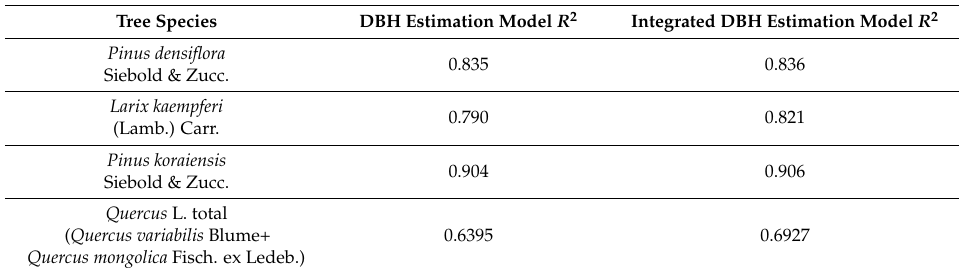
Table 8. Correlation between observed and estimated DBH for each model (DBH estimation model R 2 , integrated DBH estimation model R 2 ).